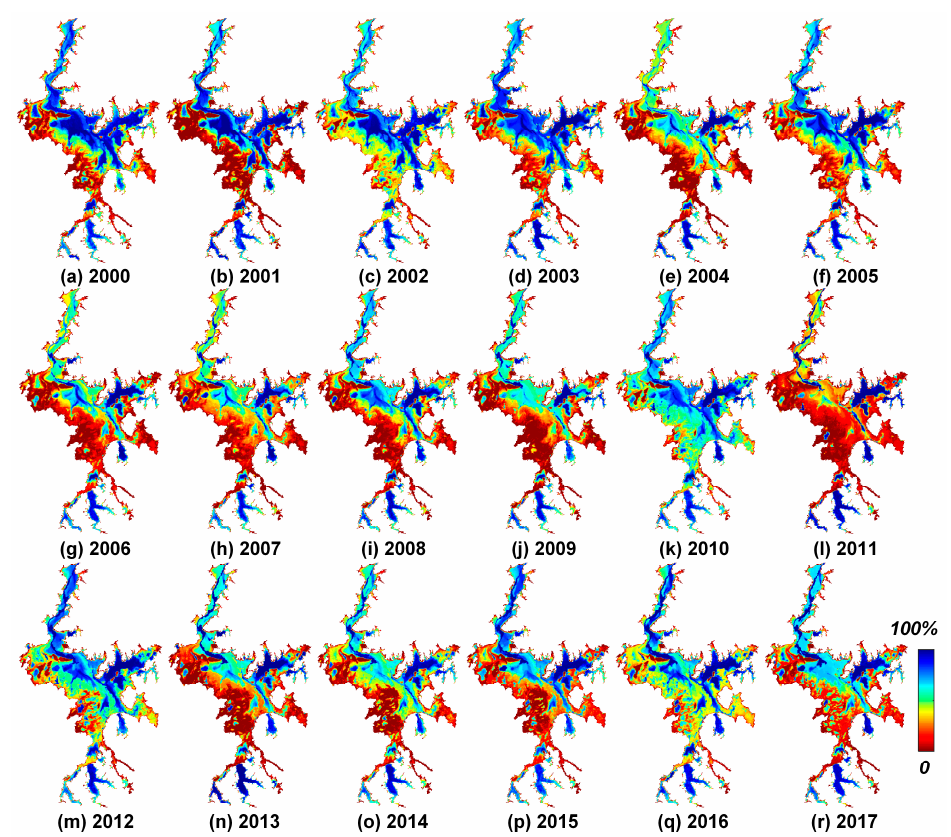
Figure 11. Map of mean submersion time for the Poyang Lake in 2000–2017. Lake surfaces are derived using the MinVC NDVI.